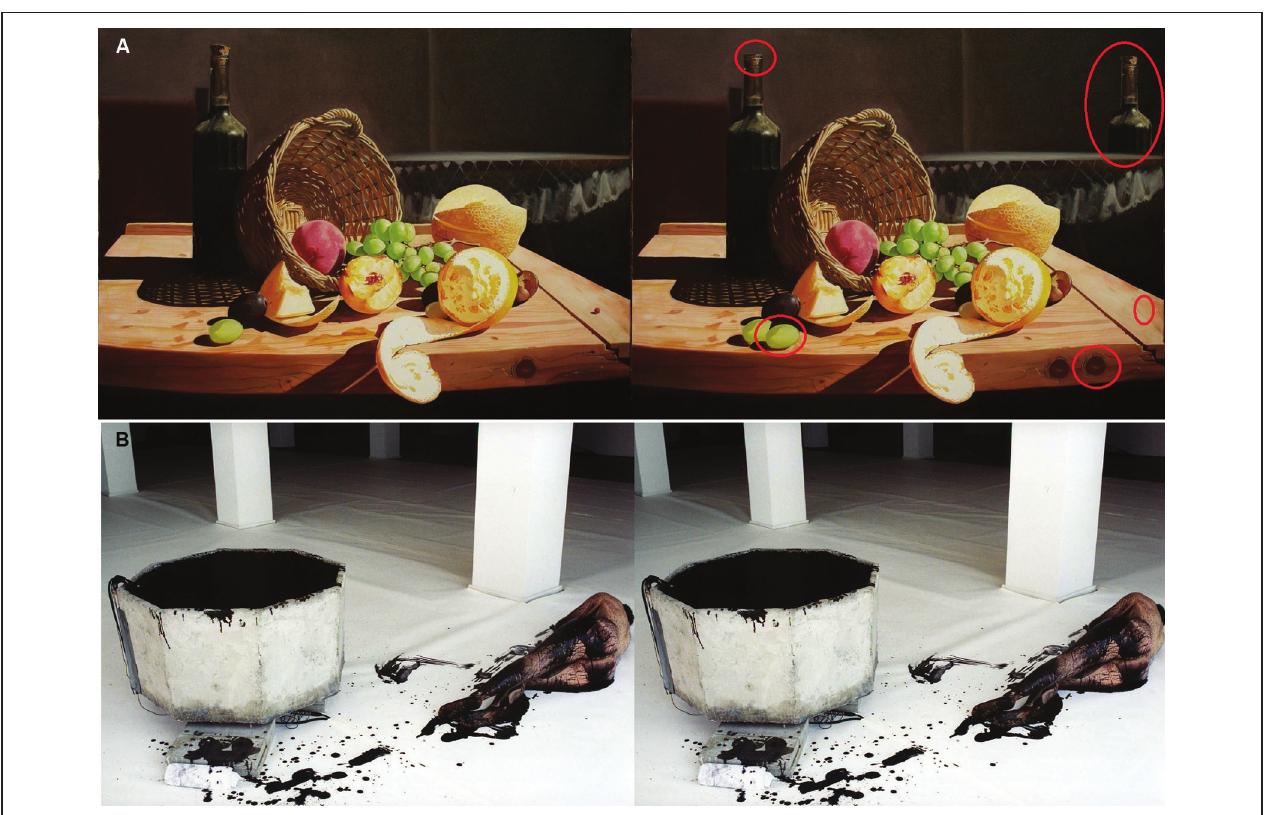
FIGURE 1 | (A) Pictures used in the positive SD task (“Best Abstract” © Adrian Borda). The right image has slight differences to the left image, differences are circled in red. (B) Two identical images used during negative EI (Monika Weiss “Elytron” 2003,